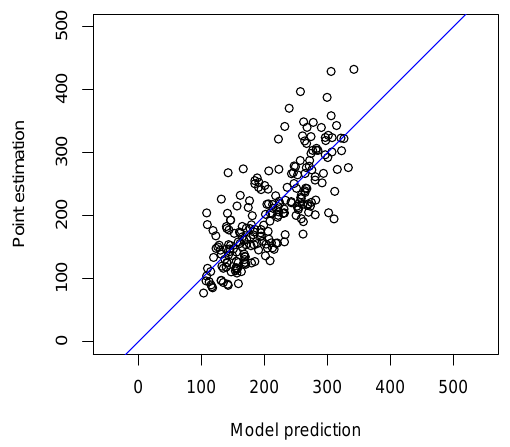
Fig. 1. Scatter plot of GEV parameters location ( µ ) against scale ( σ ) estimated for every station. The line added corresponds to linear regression. Fig.2. Scatter plot of 100-year return levels estimatedlocally versus the return levels predicted by RS ref . Pearsons correlation is 0.73.